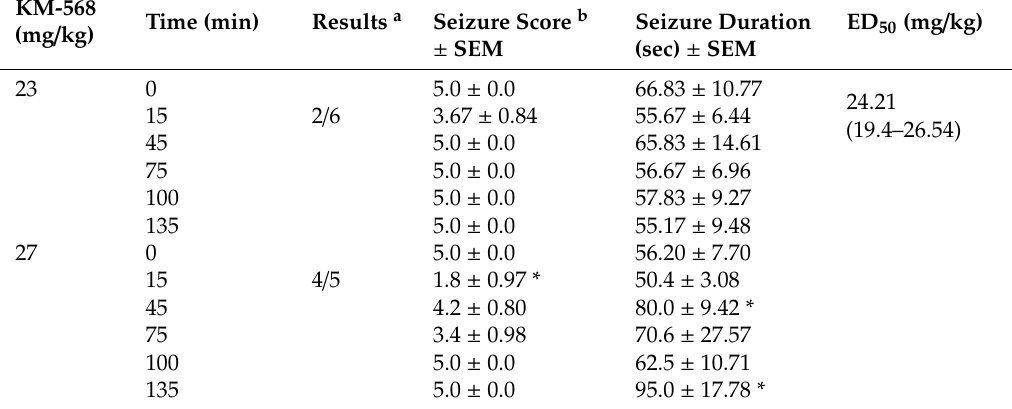
Results of a hippocampal kindled rat model after intraperitoneal administration of compound KM-568.